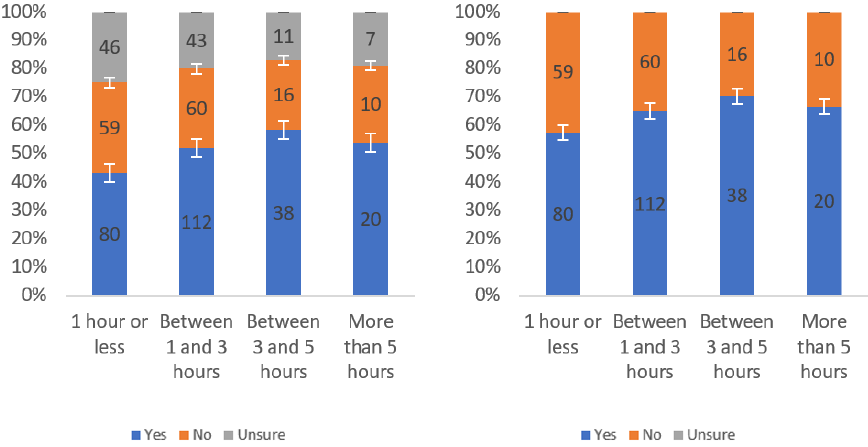
Figure A15. Responses regarding usefulness in judging trustworthiness by internet usage level including ( left ) and excluding ( right ) unsure